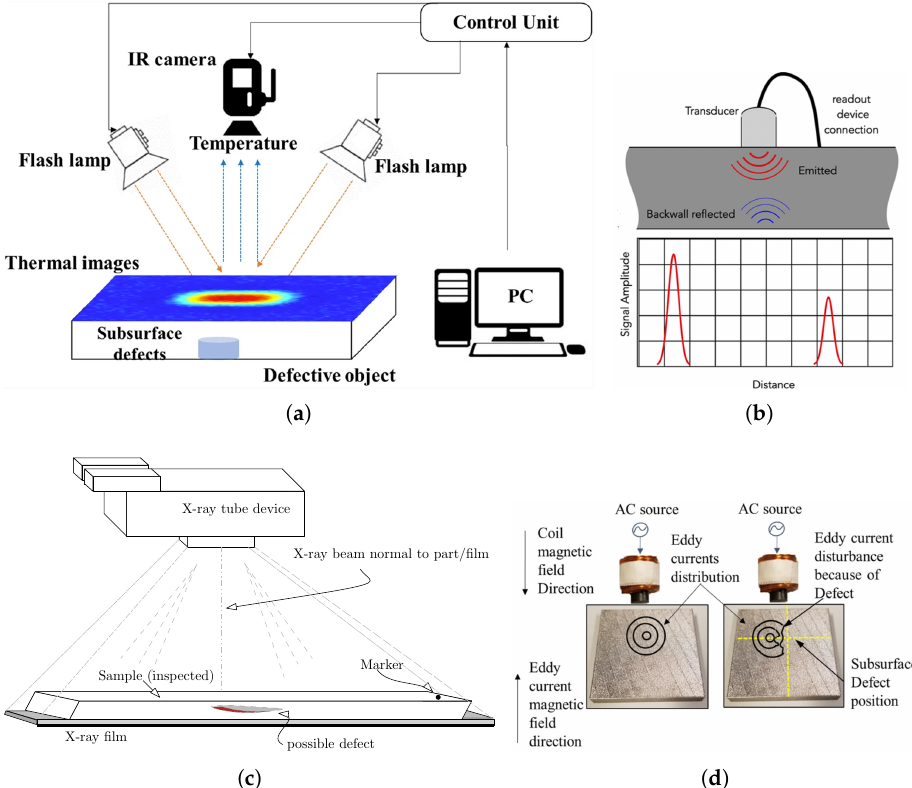
Figure 1. Basic representations of thermographic, ultrasonic, X-ray and eddy current NDT meth- ods. ( a ) Schematic representation of pulsed thermography [23]. ( b ) Schematic representation of ultrasonic testing [24]. ( c ) Schematic representation of X-ray radiography. ( d ) Eddy current defect representation